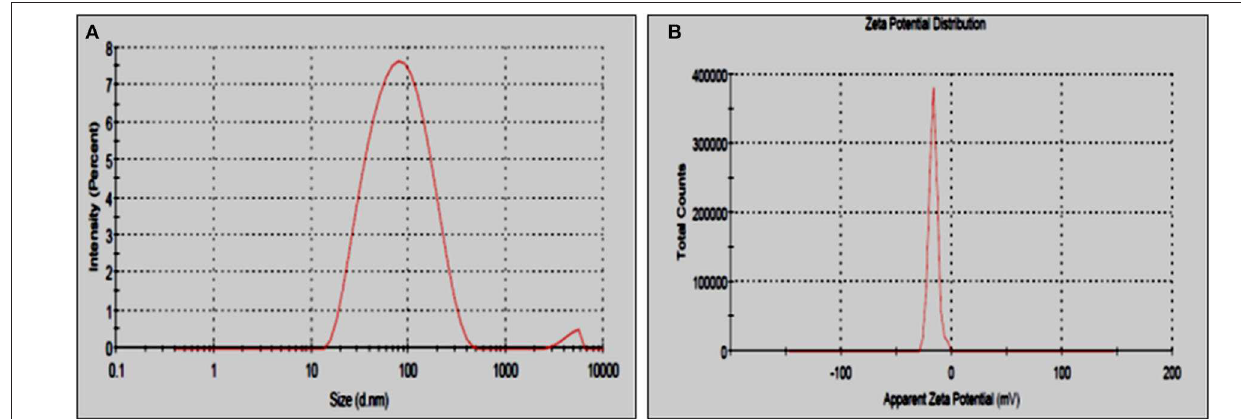
FIGURE 5 | (A) DLS and (B) zeta potential of optimized AuNPs.